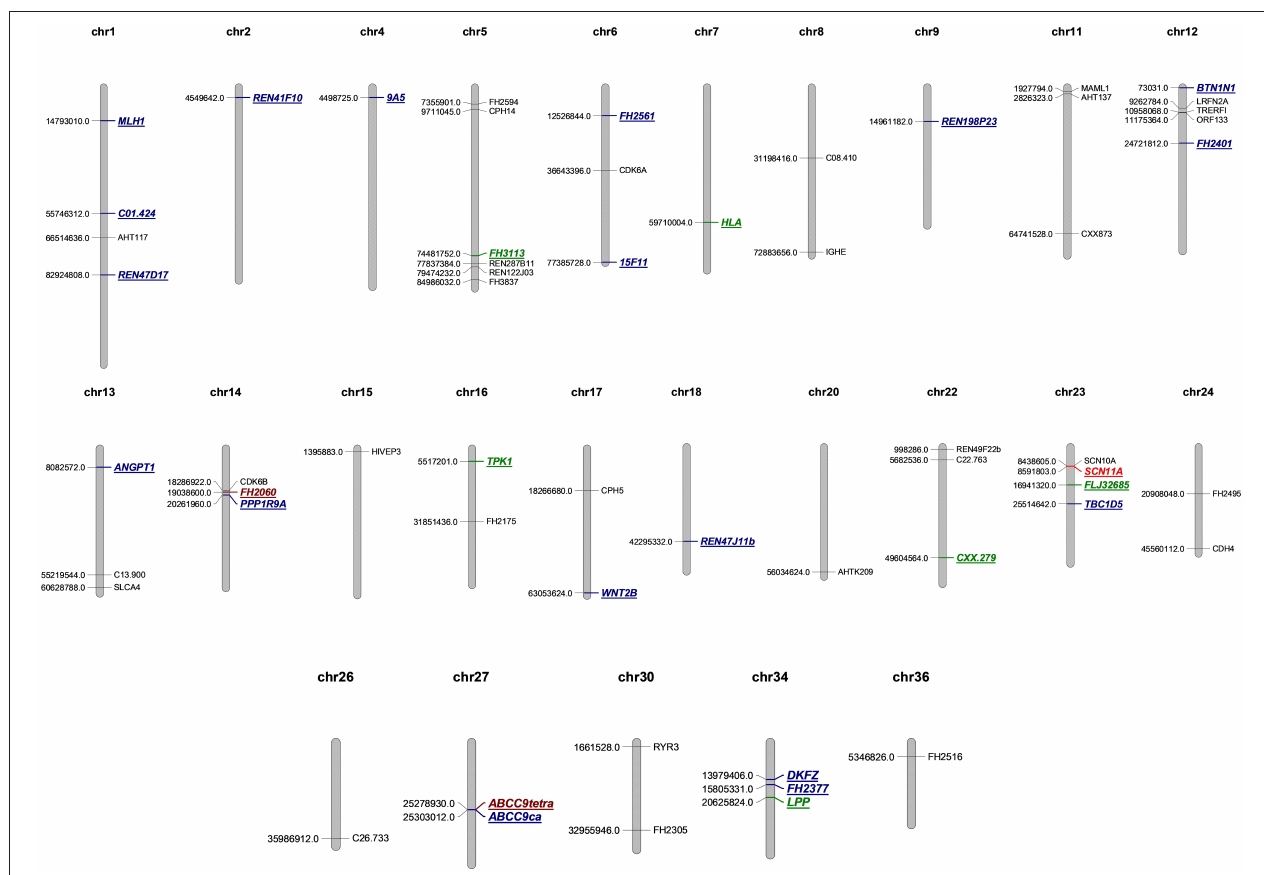
FIGURE 3 | Genome map of microsatellite loci in this study. MSS are depicted in black, the single mutation of microsatellite loci is labeled blue, twice mutation is green, four times mutation is brown, and six is marked in red.